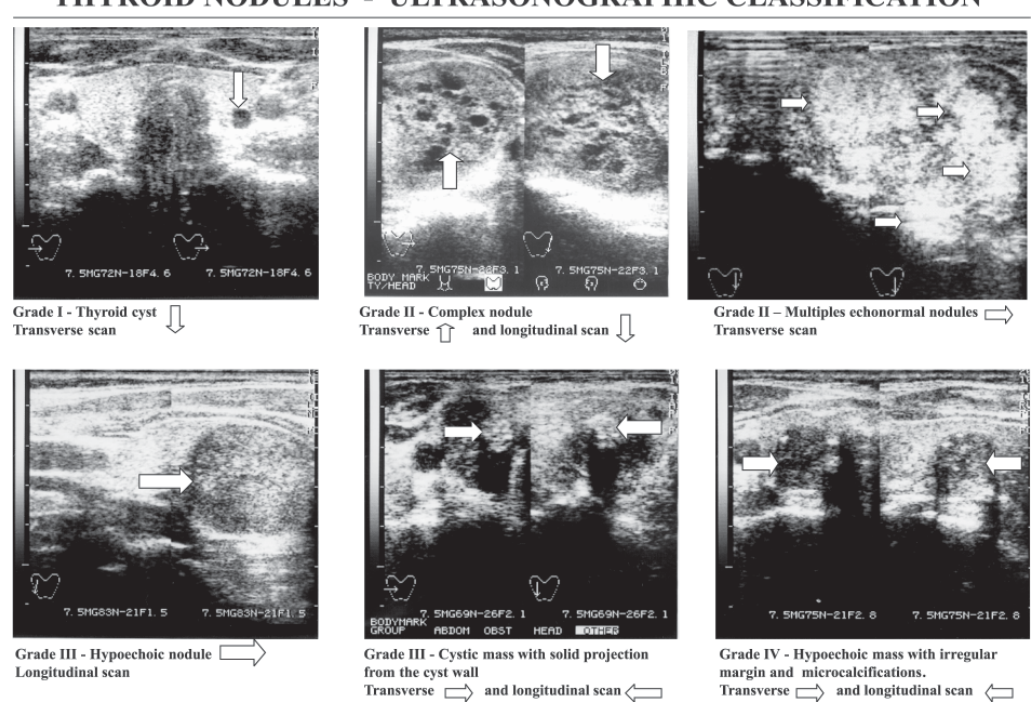
Figure 1 - Ultrasonographic classification of nodules. From top left, clockwise: grade I, a small round anechoic image (thyroid cyst); grade II, a complex nodule (like a sponge); grade II, multiple echonormal nodules; grade III, a hypoechoic solid nodule with regular border; grade III, cystic mass with solid projection from the cyst wall; and grade IV, a hypoechoic solid nodule with irregular border and